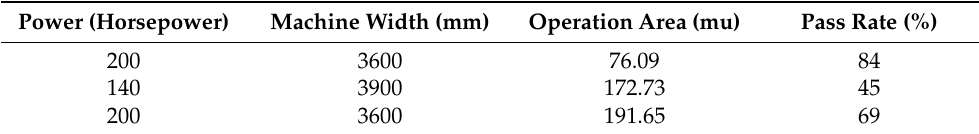
Table 3. Different operation quality of different types of agricultural machinery. Power (Horsepower)